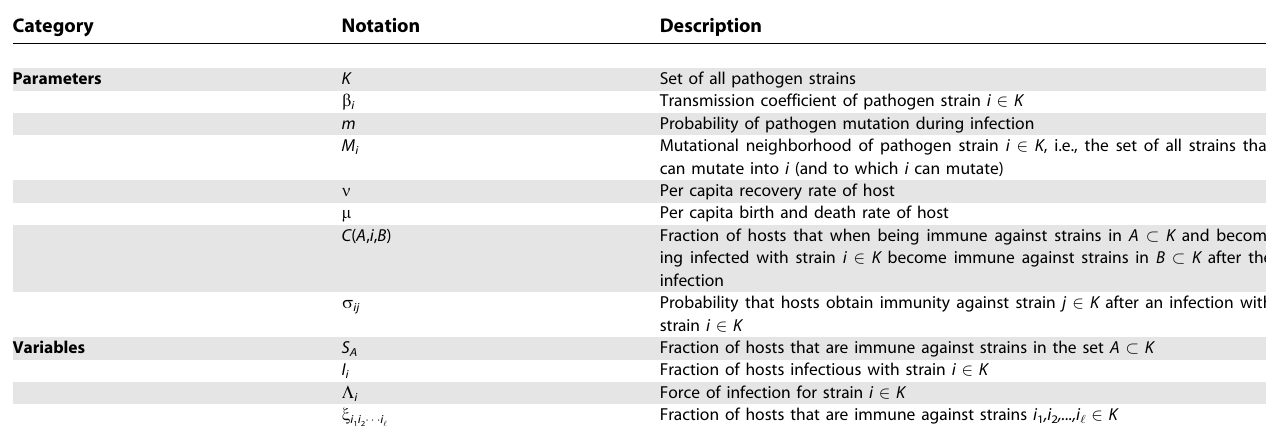
Table 1. Notations Used Throughout This